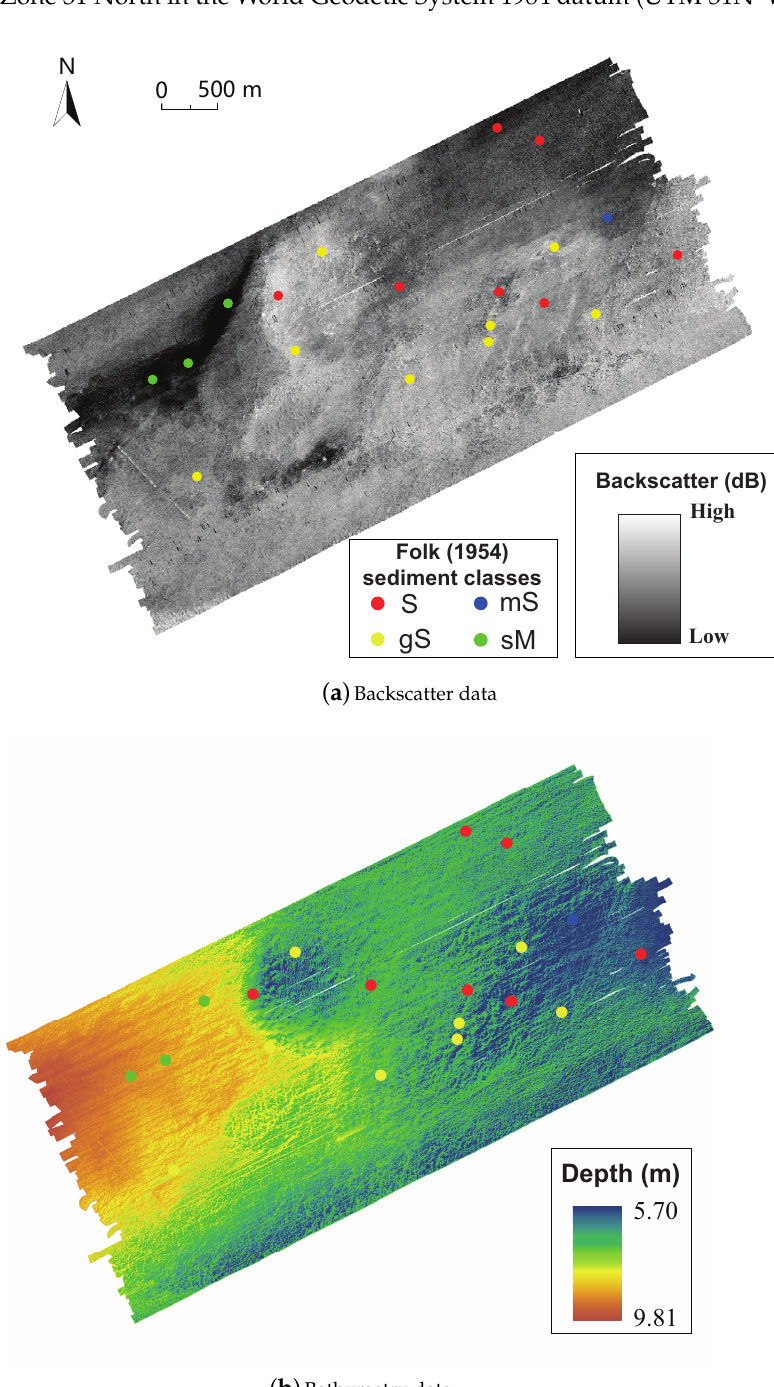
Figure 2. Map of the study area with backscatter and bathymetry and the location of the sediment samples. The bathymetry map is overlaid with a hill-shade layer, in which the vertical exaggeration Z is set 2, the sun azimuthal illumination orientation is 315 and the altitude is